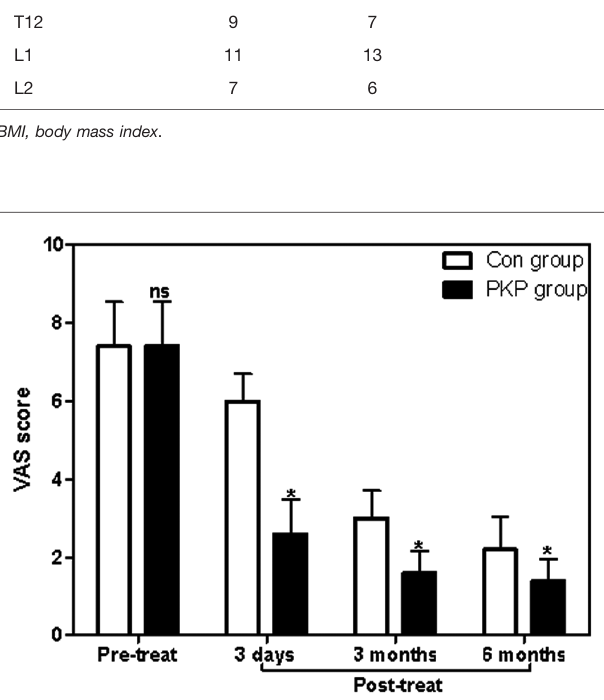
FIGURE 1 | Comparison of VAS scores at different times between two groups. Note: Compared with the Con group, ns P >0.05 and * P